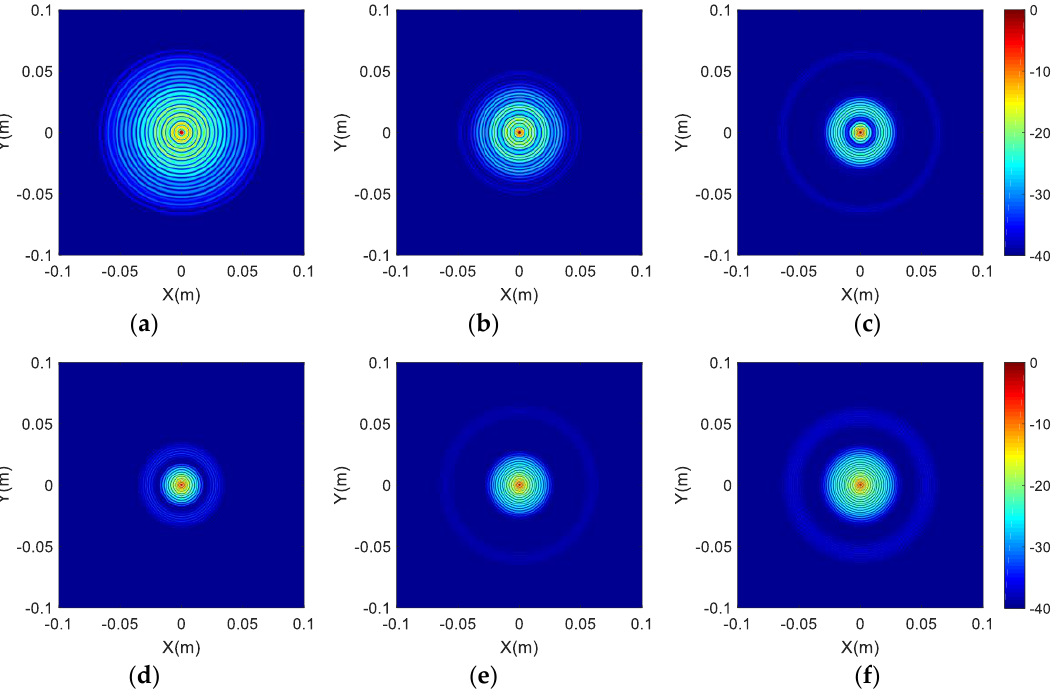
Figure 6. The two-dimensional imaging results at (0, 0): ( a ) Type I; ( b ) Type II; ( c ) Type III; ( d ) Type IV; ( e ) Type V; ( f ) Type VI.